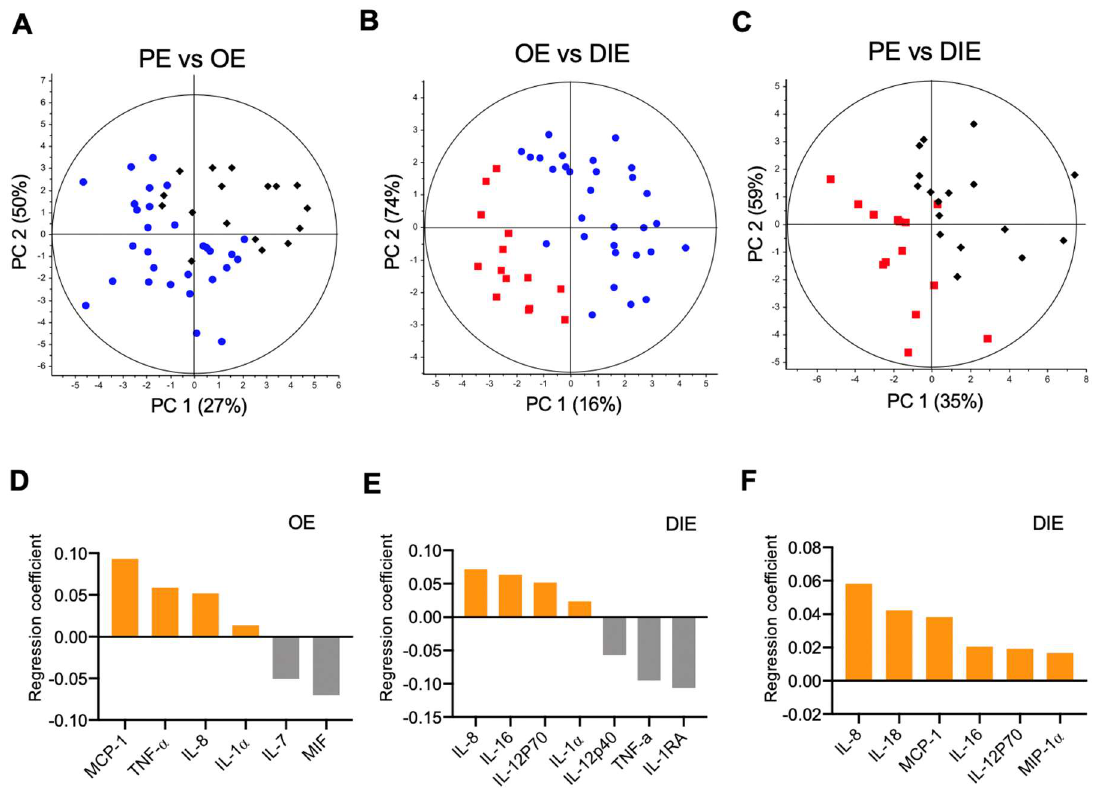
Figure 2. Peritoneal fluid cytokines show distinct delineation of endometriosis subphenotypes. Partial least squares regression (PLSR) models separated ( A ) ovarian endometriomas from peritoneal endometriosis, ( B ) ovarian endometriomas from deep infiltrating endometriosis, and ( C ) peritoneal endometriosis from deep infiltrating endometriosis. The principal component (PC) scores show good separation of endometriosis subphenotypes by using PF cytokines. ( D – F ). Corresponding PLSR coefficient analyses reveal cytokine signatures delineating the various subphenotypes. Elevated cytokines associated with a particular endometriosis subphenotype (OE, PE, or DIE) relative to its comparator appear in the same upper or lower half of the plot.